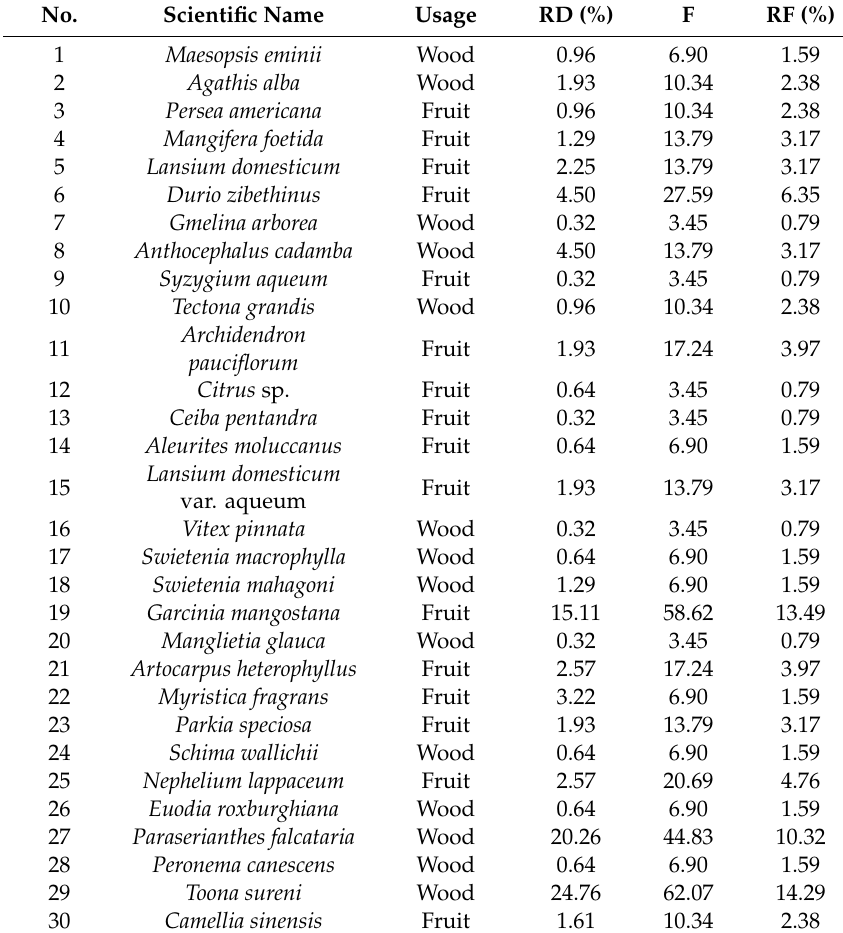
Table 9. List of tree species planted in home gardens in the study sites and characteristics of a quantitative stand